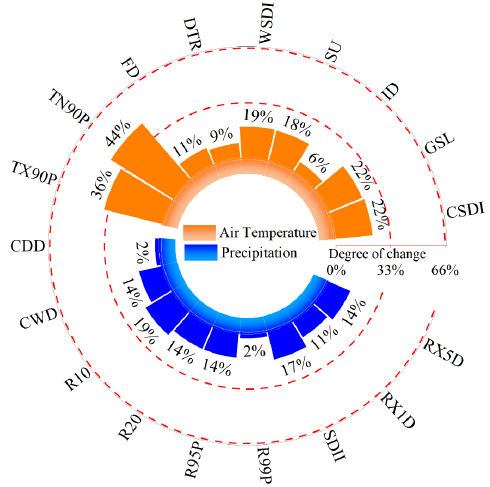
Figure 7. Extreme precipitation and temperature change